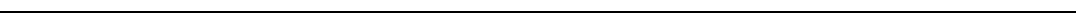
Fig. 4 Excessive proliferation of non-targeted VEGFR3 + LECs contributes to lymphatic vessel hyperplasia in Vegfr3 -deleted ears. a , b Fluorescence- activated cell sorting (FACS) evaluation of Tomato and GFP expression in Vegfr3 fl ox/ + and Vegfr3 fl ox/ fl ox ; R26-mTmG;Prox1-CreER T2 LECs. Tamoxifen (150 µ g) was administered daily from P2 until harvest at P11 – P12. Representative dot plots of GFP and Tomato expression, and histogram of Tomato expression in GFP + LECs are displayed with Cre − littermate as a control. In b , graph of combined results from two litters, showing the average distribution of cells expressing Tomato only (red), GFP and Tomato (yellow), and GFP only (green). Dots show % of GFP + LECs in individual mice, horizontal line represents mean ( n = 3 mice) ± s.e.m. c Vegfr3 exon1 deletion (left) and mRNA expression (right) in sorted Tomato + GFP − (red), Tomato + GFP + (yellow), and Tomato −